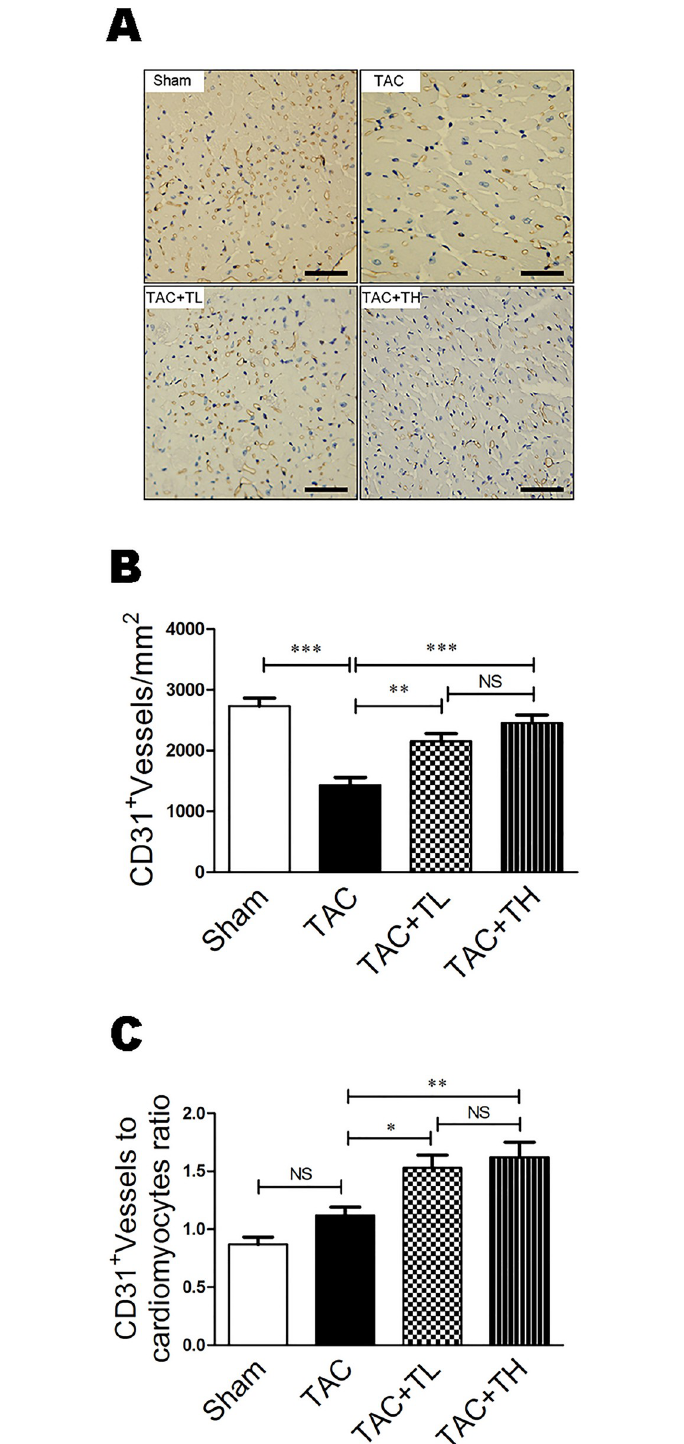
Fig 4. TXL promotes myocardial capillarity after TAC. ( A ) Representative immunostaining of LV myocardial capillaries (CD31+) at 12 weeks post-surgery. ( B ) Quantification of LV myocardial capillary density at 12 weeks post- surgery. ( C ) Capillary number/cardiomyocyte ratios at 12 weeks post-surgery. Data are mean ± SEM, n = 5 per group. � P < 0.05, �� P < 0.01, ��� P < 0.001. NS, not significant.